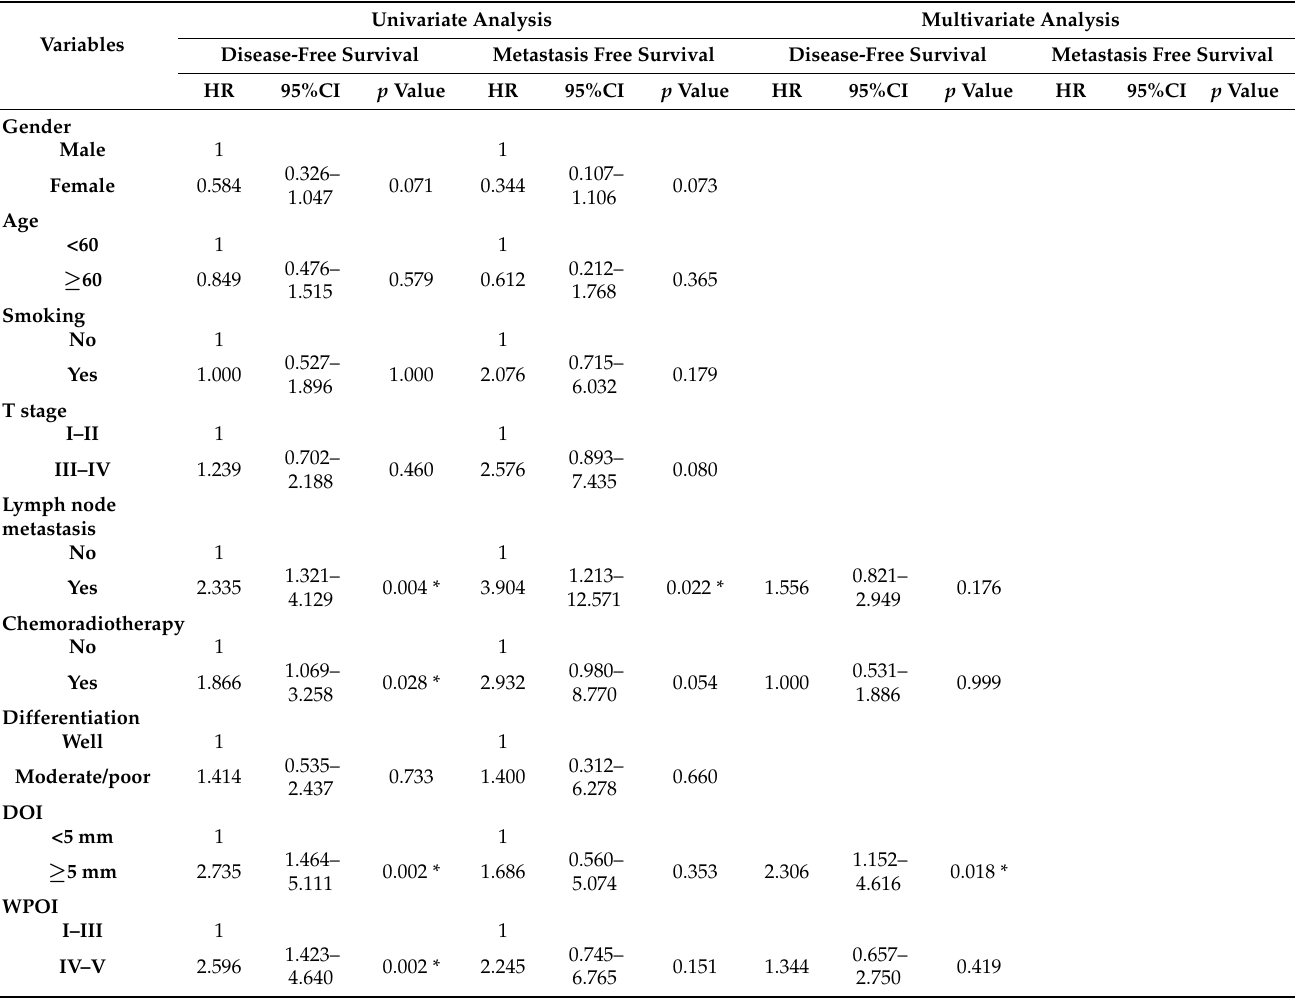
Table 3. Cox-regression analysis of DFS and MFS in OSCC